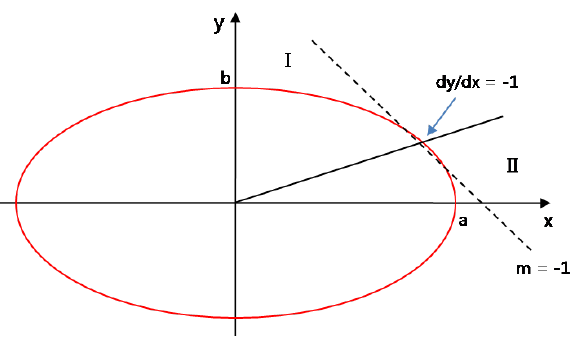
Figure 8. Basic structure to create an ellipse.